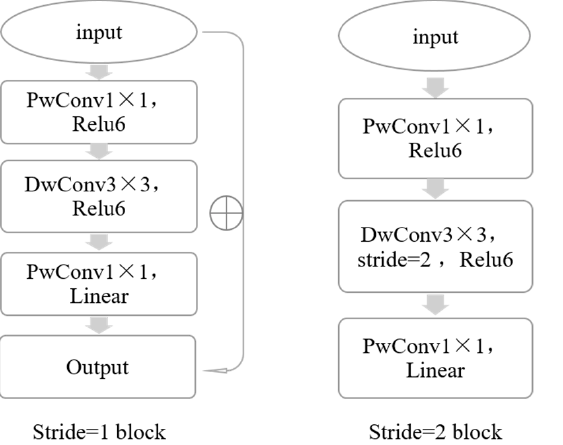
Figure 4. The general construction of the bottleneck layer of the MobileNetV2 network, referenced from from [23].